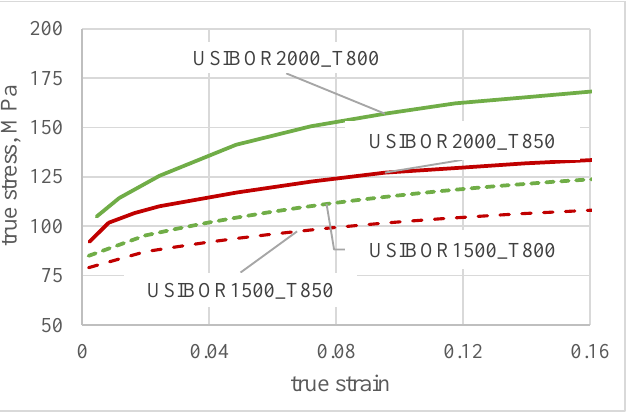
0.01 s −1 and temperatures of 800 °C and 850 °C.